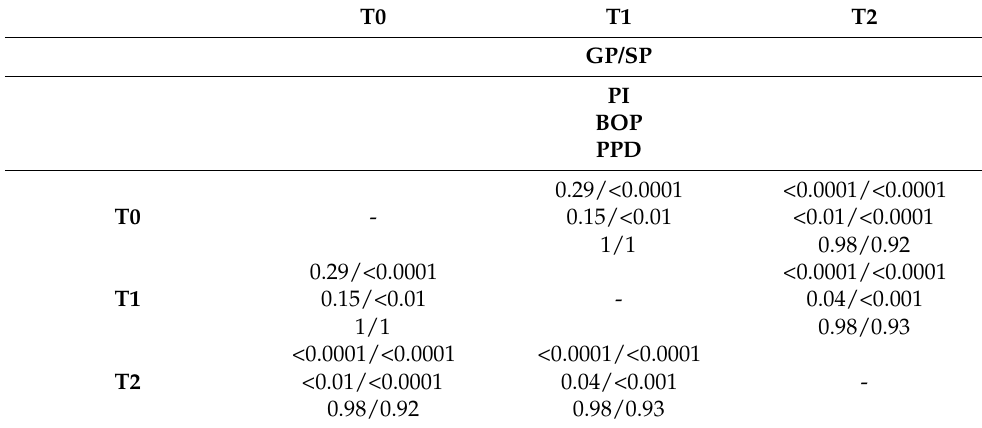
Table 3. Differences among moments of examination regarding PI, BOP, PPD, in GP and SP ( p ).